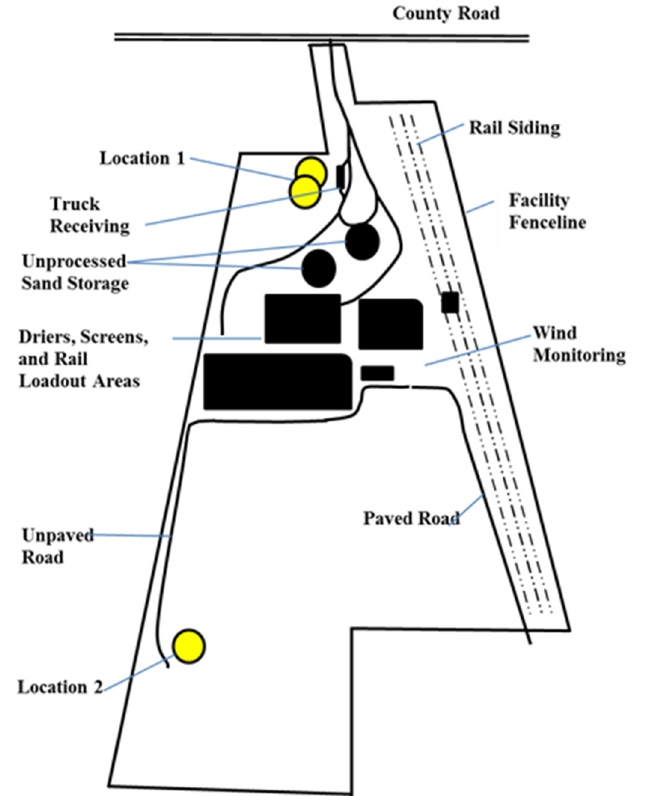
Figure 1. Chippewa Falls sampler locations.